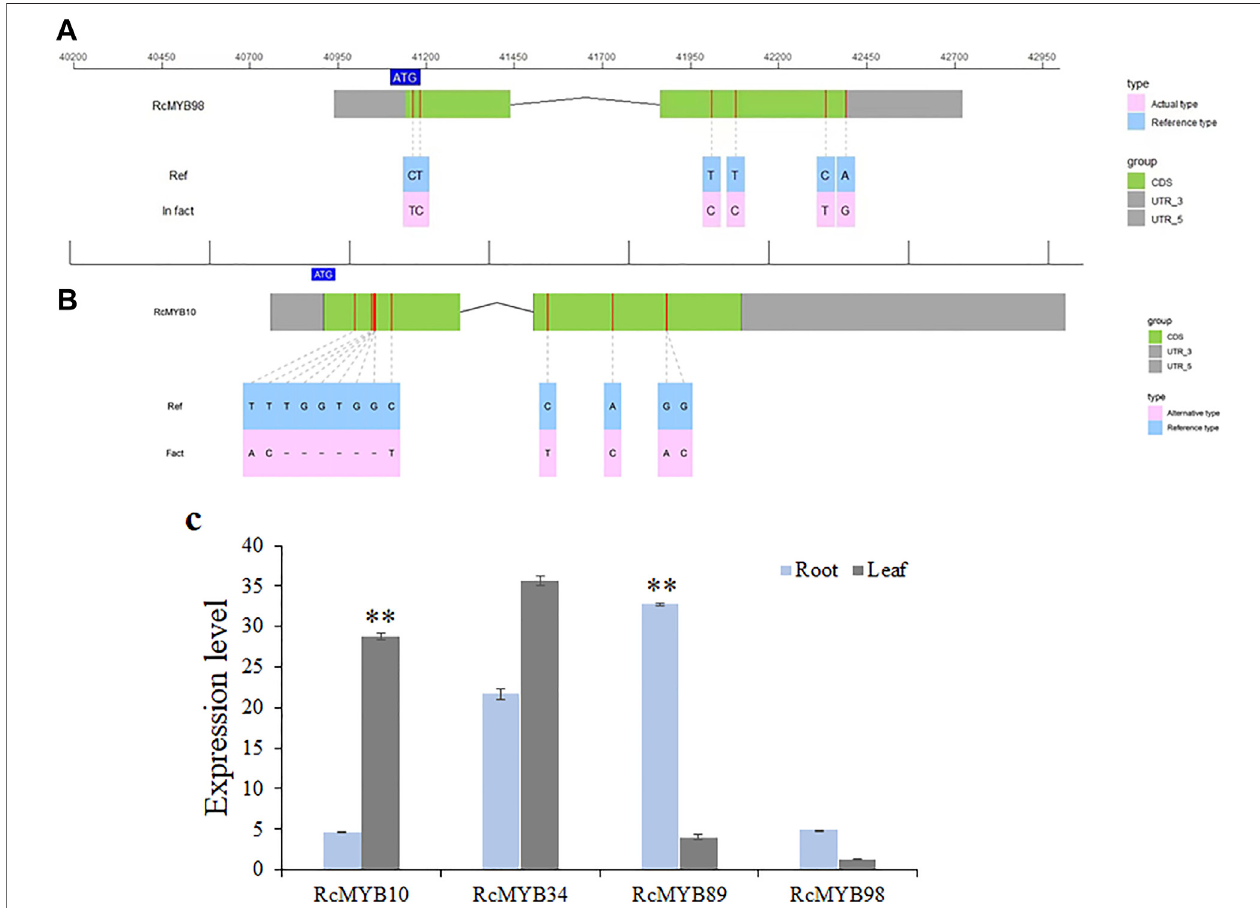
FIGURE6| GenecloningandexpressionlevelanalysisofclusteredRcMYBs. (A) Cloningandsequencingof RcMYB98 . (B) Cloningandsequencingof RcMYB10 . (C) Expression level analysis of RcMYB10 , RcMYB34 , RcMYB89, and RcMYB98 in root and leaf. Values are the mean ± standard deviation ofthree biological replicates per treatment. “ ** ” above each column indicates a signi fi cant difference ( p < 0.01; n = 3).